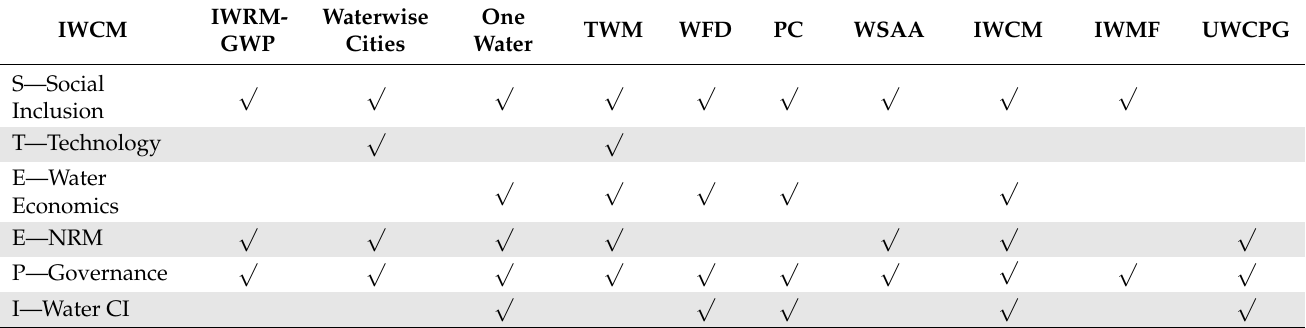
Table 1. Comparison of IWCM interpretations in the STEEPI